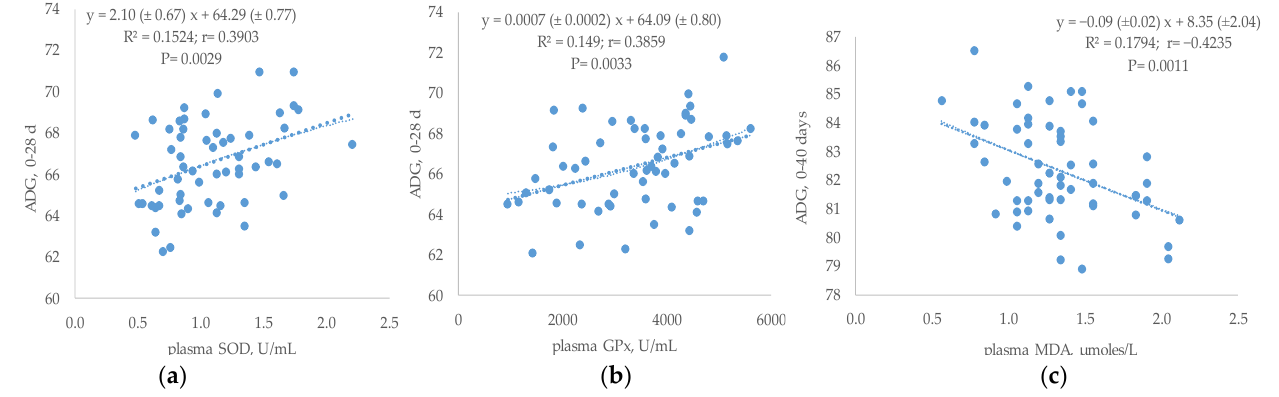
Figure 1. Relationship between ADG (g) and plasma antioxidant status measured as SOD (U/mL) ( a ), GPx (U/mL) ( b ) or MDA concentrations ( µ moles/L) ( c ). In addition, inverse relationships were observed between plasma MDA and other blood compounds as indicators of antioxidant status (Figure 2a,b). As a result, plasma MDA concentration was negatively correlated with plasma vitamin E (r = − 0.53; p = 0.0001) (Figure 2a) and with GPx (r = − 0.32; p = 0.0043) (Figure 2b) following a linear adjustment.